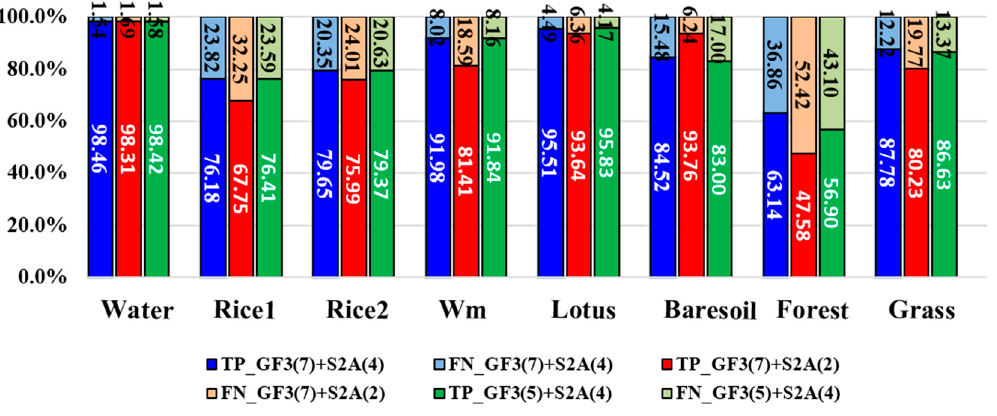
Figure 10. The true positive (TP) rates and the false negative (FN) rates of different land covers generated from different combination of features. Wm means watermelon.